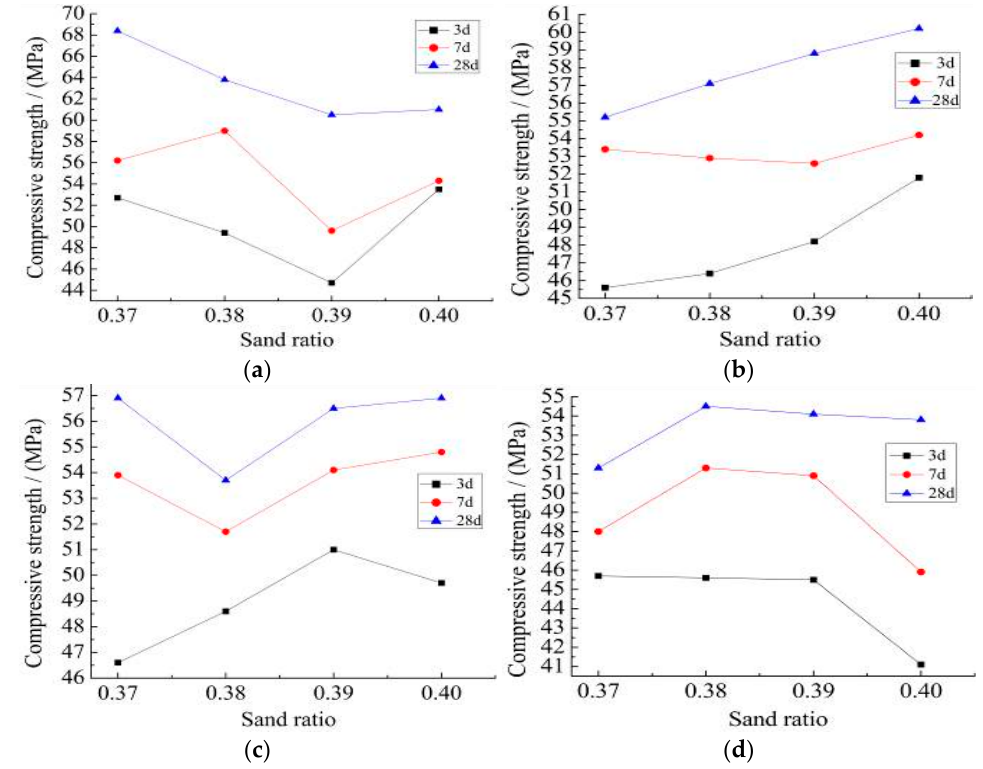
Figure 7. ( a ) NC-0, ( b ) RC-30, ( c ) RC-40, ( d ) RC-50.